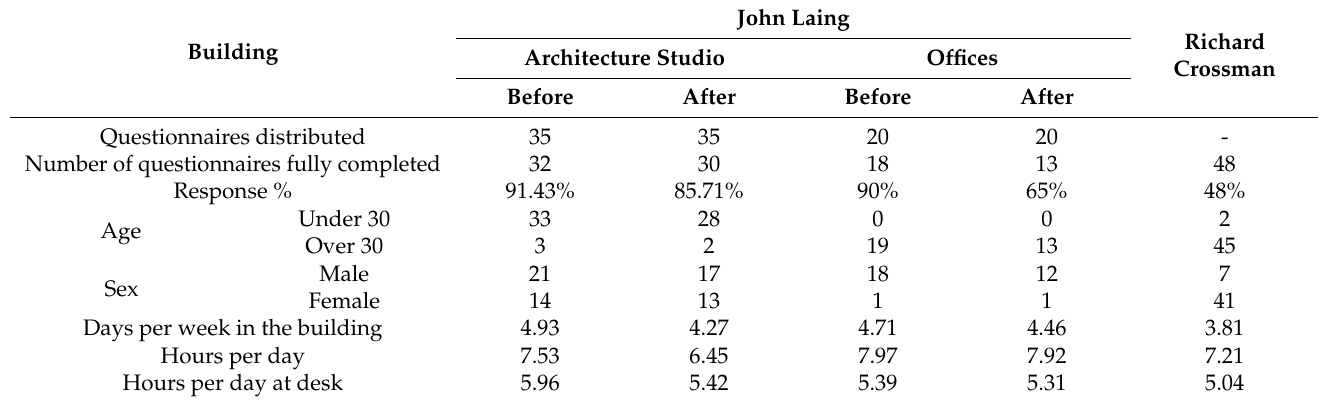
Table 7. Characteristics of